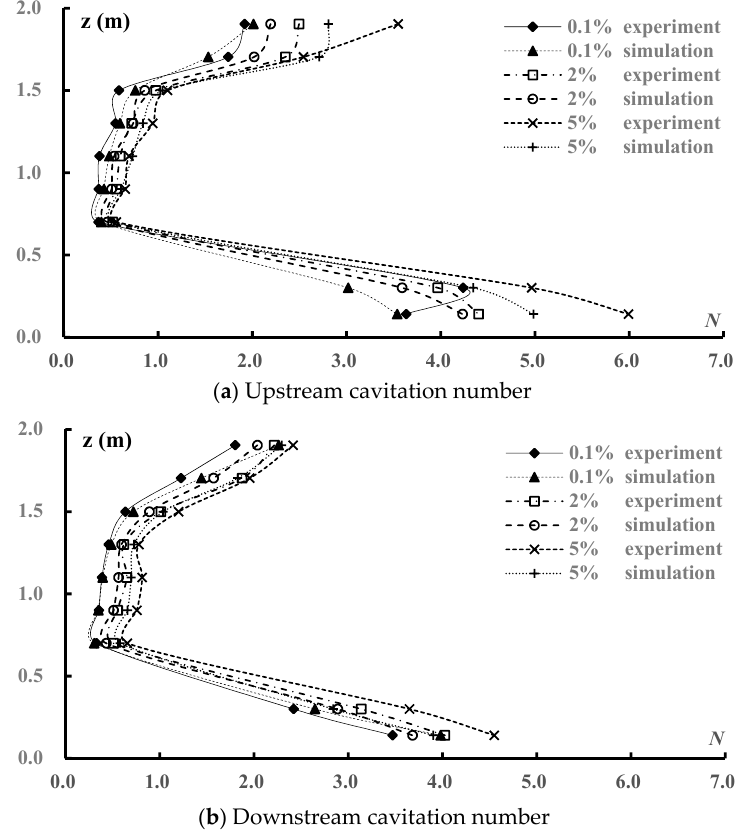
Figure 15. Cavitation number in the vortex drop shaft.